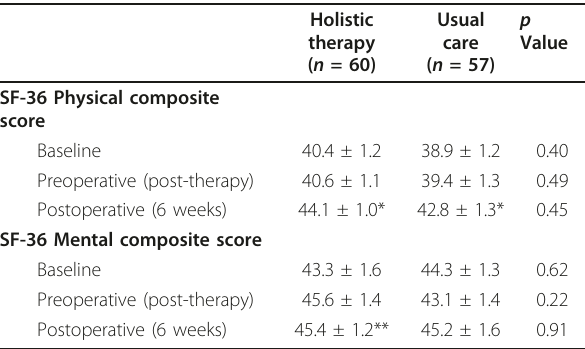
Table 3 Quality of life measurements at different time